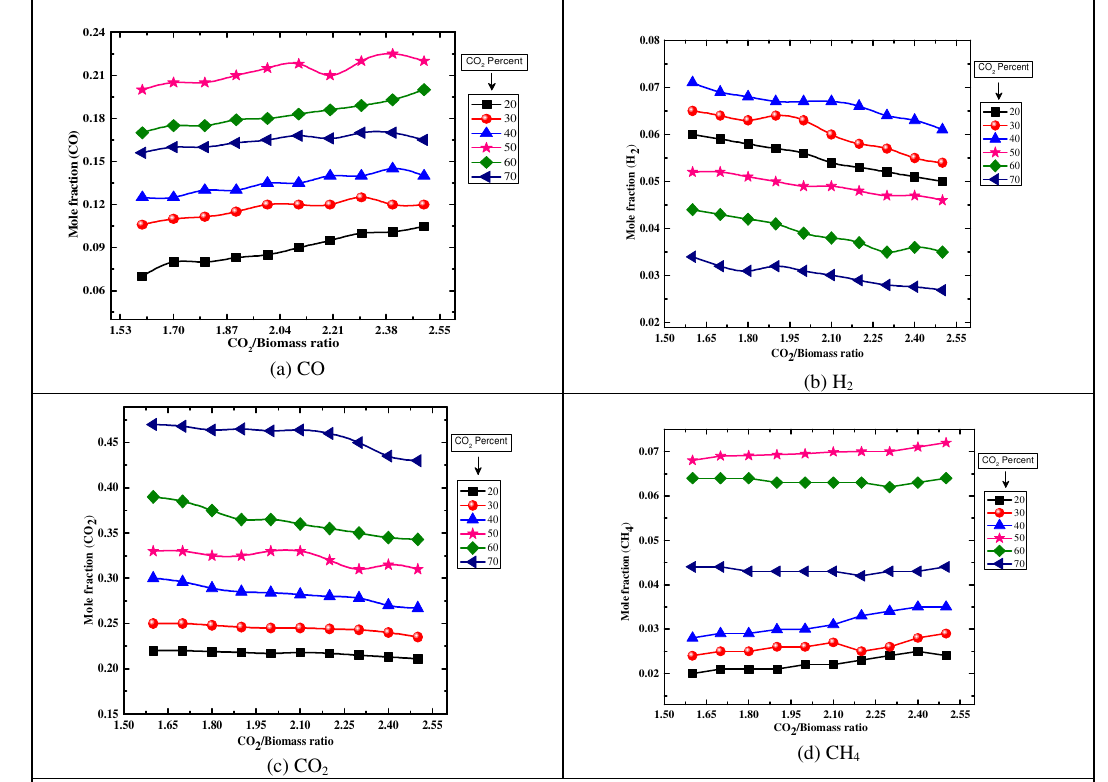
FIG. 5. UNDER DIFFERENT CO 2 % IN AIR AND ITS EFFECT ON SYNGAS QUALITY and its effect on the quality of syngas composition at the outlet of the entrained flow gasifier is shown. As mentioned earlier the cotton stalk feeding rate was maintained 61kg/hr, the increase in CO 2 /cotton stalks ratio intended that additional CO 2 was introduced to the entrained flow reactor, increased percentage of air or oxygen, due to that temperature inside the reactor